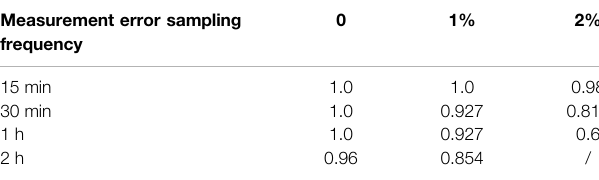
TABLE 1 | Accuracy comparison of phase recognition methods. TABLE 2 | Evaluation indicators of phase identi fi cation in different